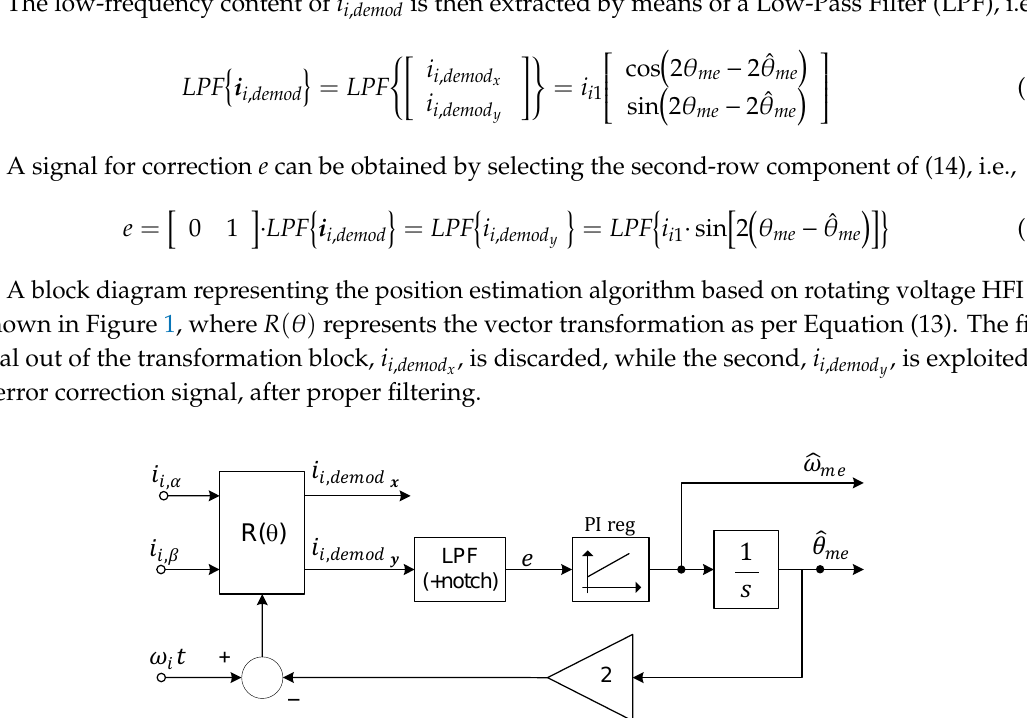
Figure 2. Equivalent block diagram of the position estimation algorithm considered for dynamics design of the loop shown in Figure 1. Considering the definition of 𝑖 𝑖1 (11), Equation (16) shows that the equivalent gain of the error signal depends on differential inductances. These vary due to magnetic saturation, which means that insufficient estimation bandwidth or, on the other hand, instability can occur if constant gains are considered in the tracking loop. In general, these effects make it difficult to obtain optimal performance in the entire range of operation with constant tracking gains. To showcase the effect of saturation, the flux-linkage maps of one of the IPM machine considered in the following simulations and experiments are reported in Figure 3.